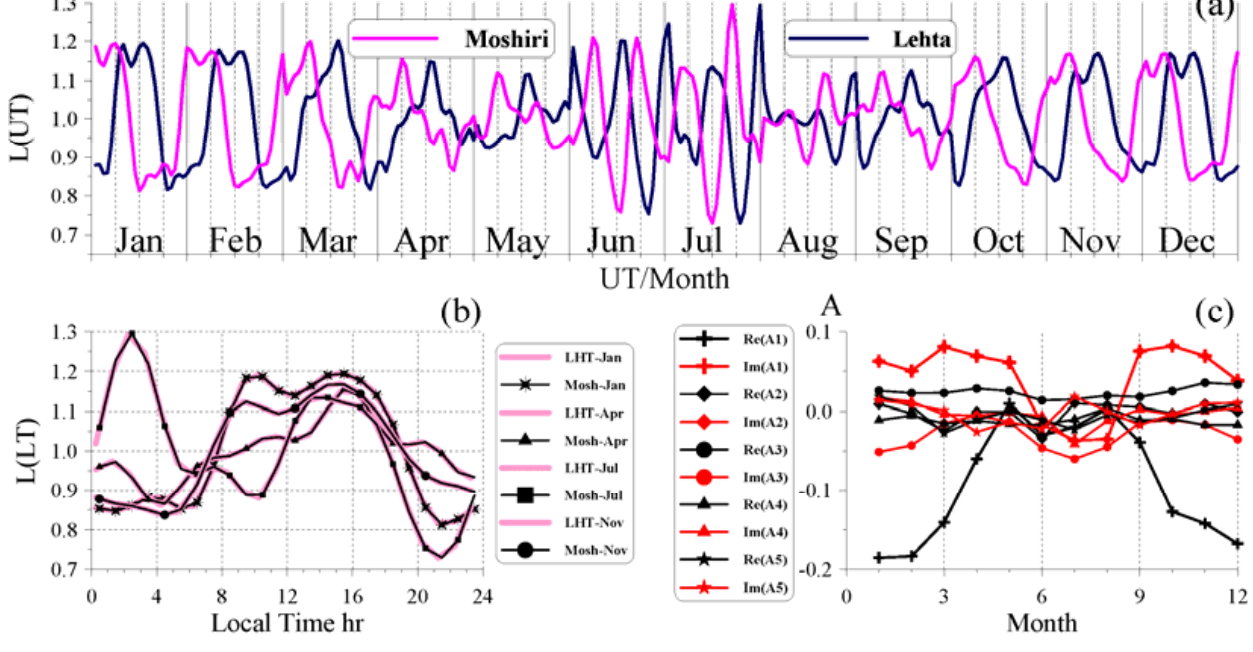
Fig. 3. Local modulation functions for Lehta and Moshiri obtained with a series of five terms in the Fourier